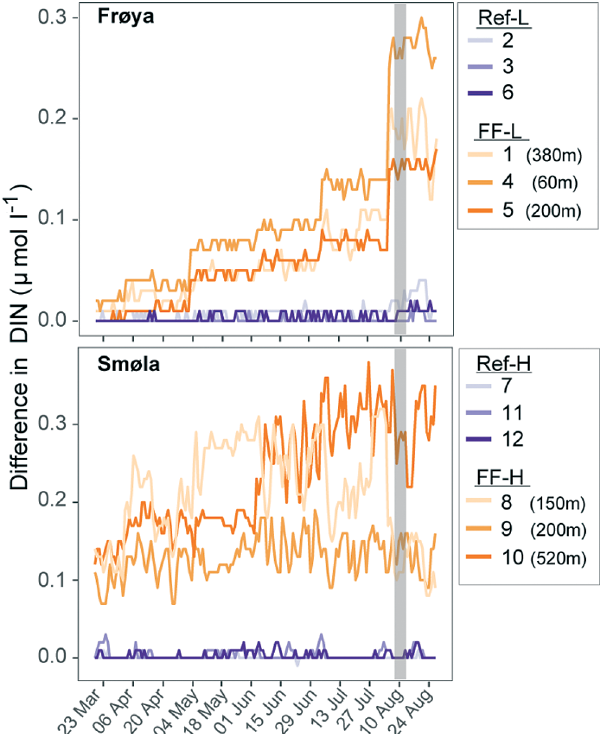
Fig. 3. Predicted effect of salmonid fish farm effluents (low levels: FF-L; high levels: FF-H) on background